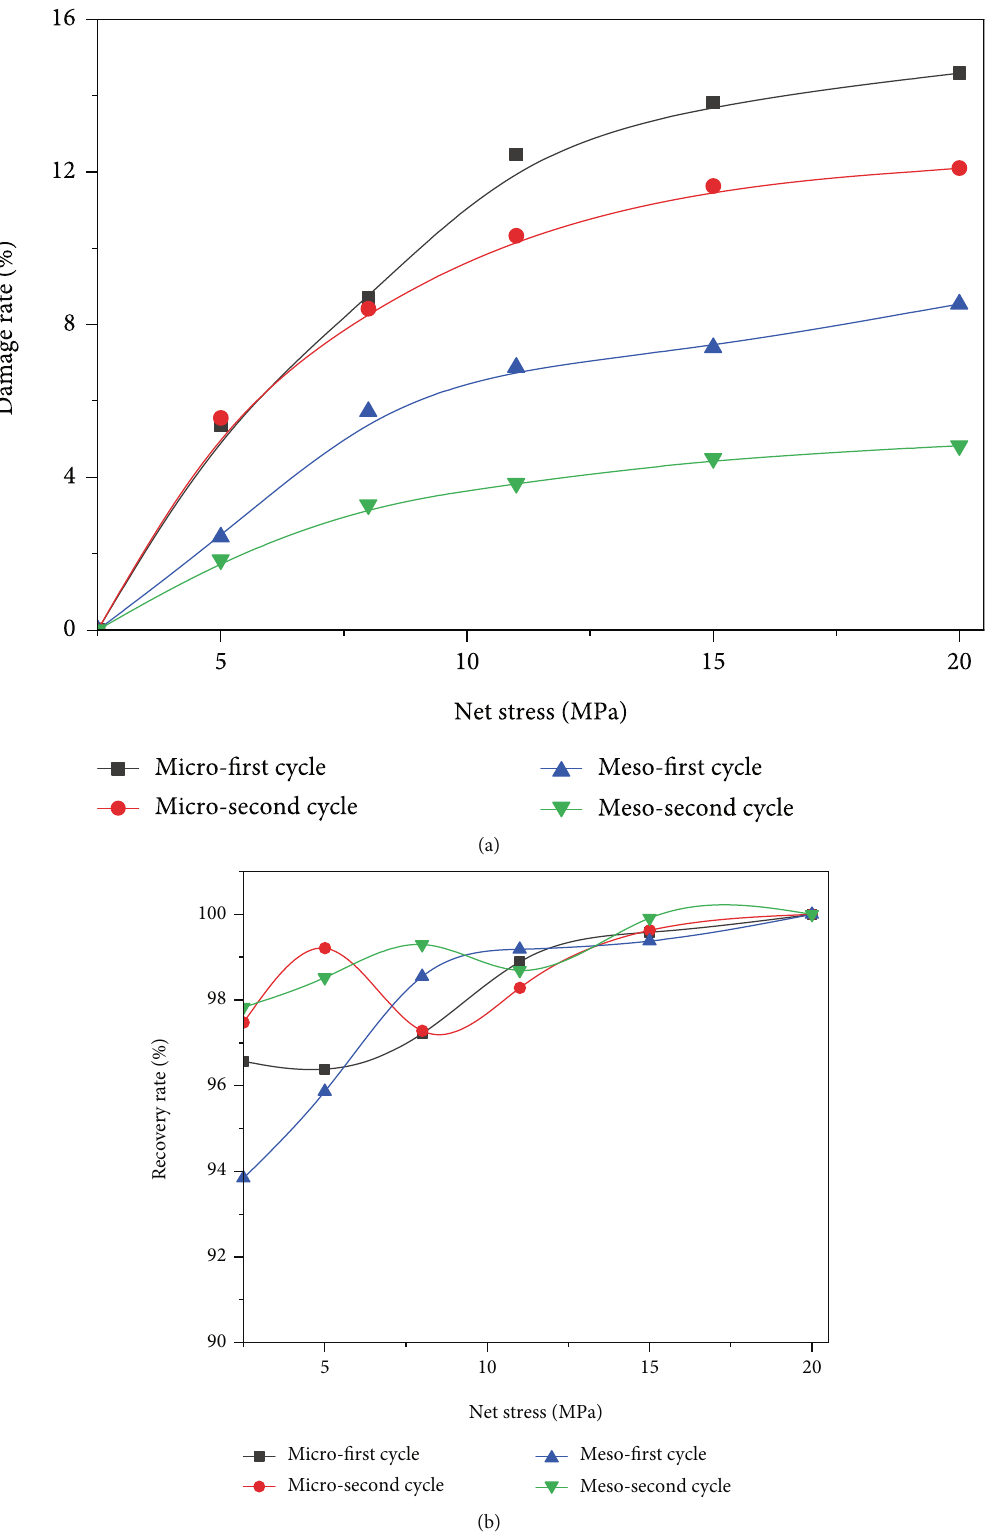
Figure 8: Damage rate and recovery rate of pore volume with di ff erent sizes under cyclic